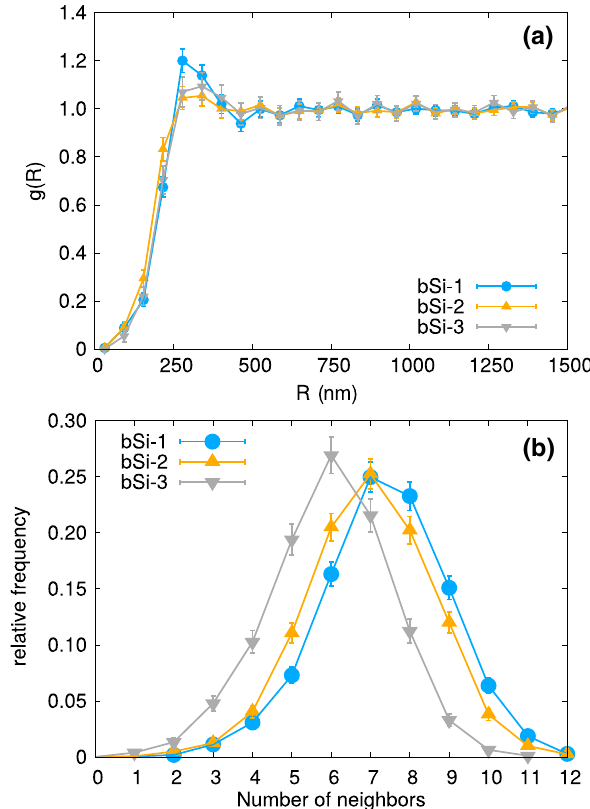
Fig. 3 Analysis for nanopillar tip distributions. a Pair-correlation function (Eq. 1) of nanopillar tip positions as a function of distance between pillars for bSi-1, bSi-2, and bSi-3 substrate. b The distri- butions of numbers of neighbors found around each pillar within the first peak of the pair-correlation function with a distance less than 500 nm